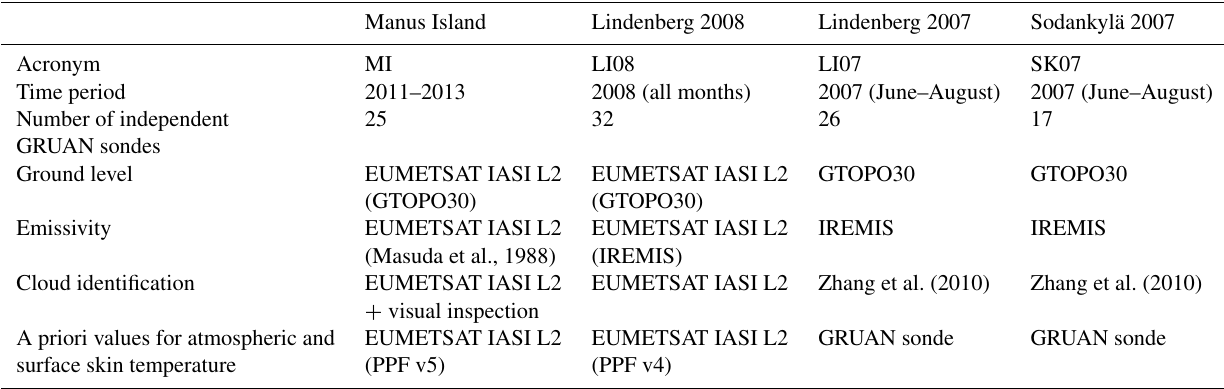
Table 1. Overview of the different ensembles of GRUAN reference data and the available retrieval input